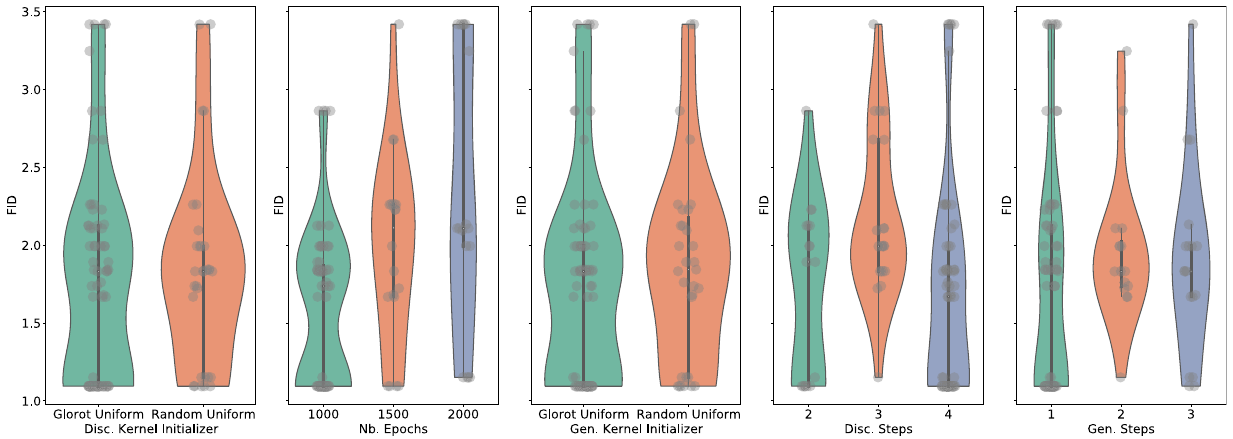
Fig. 4 Graphical representation of an hyper-parameter scan for a few selected parameters. On the y -axis is represented the different values of the FID. The violin plots represent the behaviour of the training for a given hyper-parameter. Violins with denser tails are considered better choices